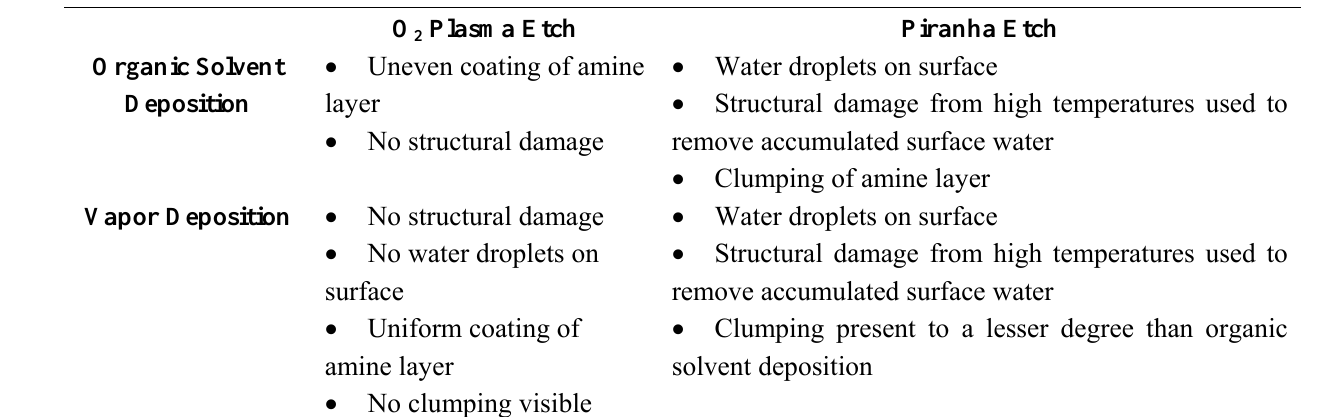
Table 1. Summary of the effects of hydroxylation and amination surface functionalization techniques on microtoroid